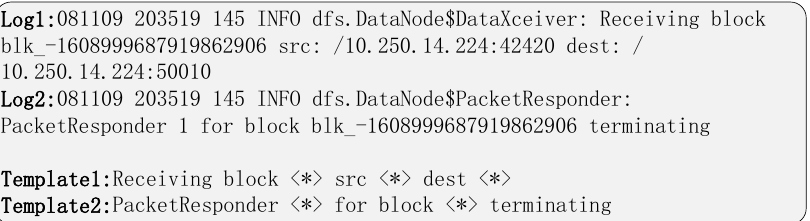
Figure 1. In the figure, Log1 and Log2 are two HDFS logs; Template1 and Template2 are their corresponding log templates.